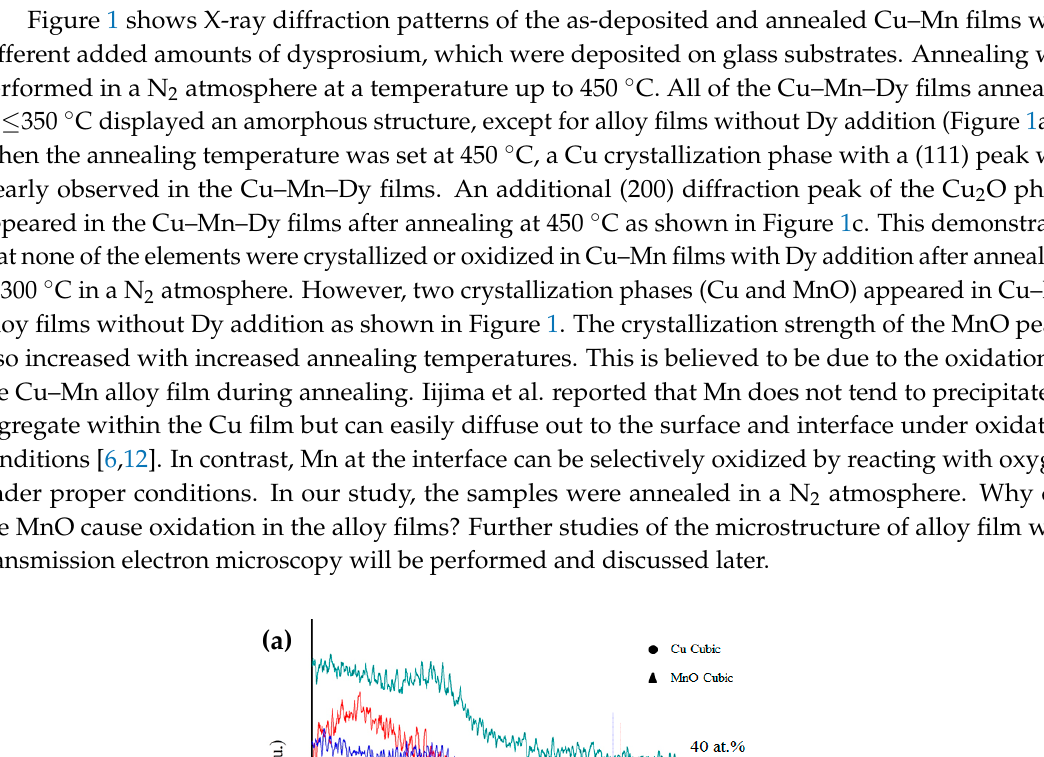
Table 1. Compositions of Cu–Mn–Dy thin films prepared at a direct current (DC) 50 W with different radio frequency (RF) powers sputtered on cooper sheet.